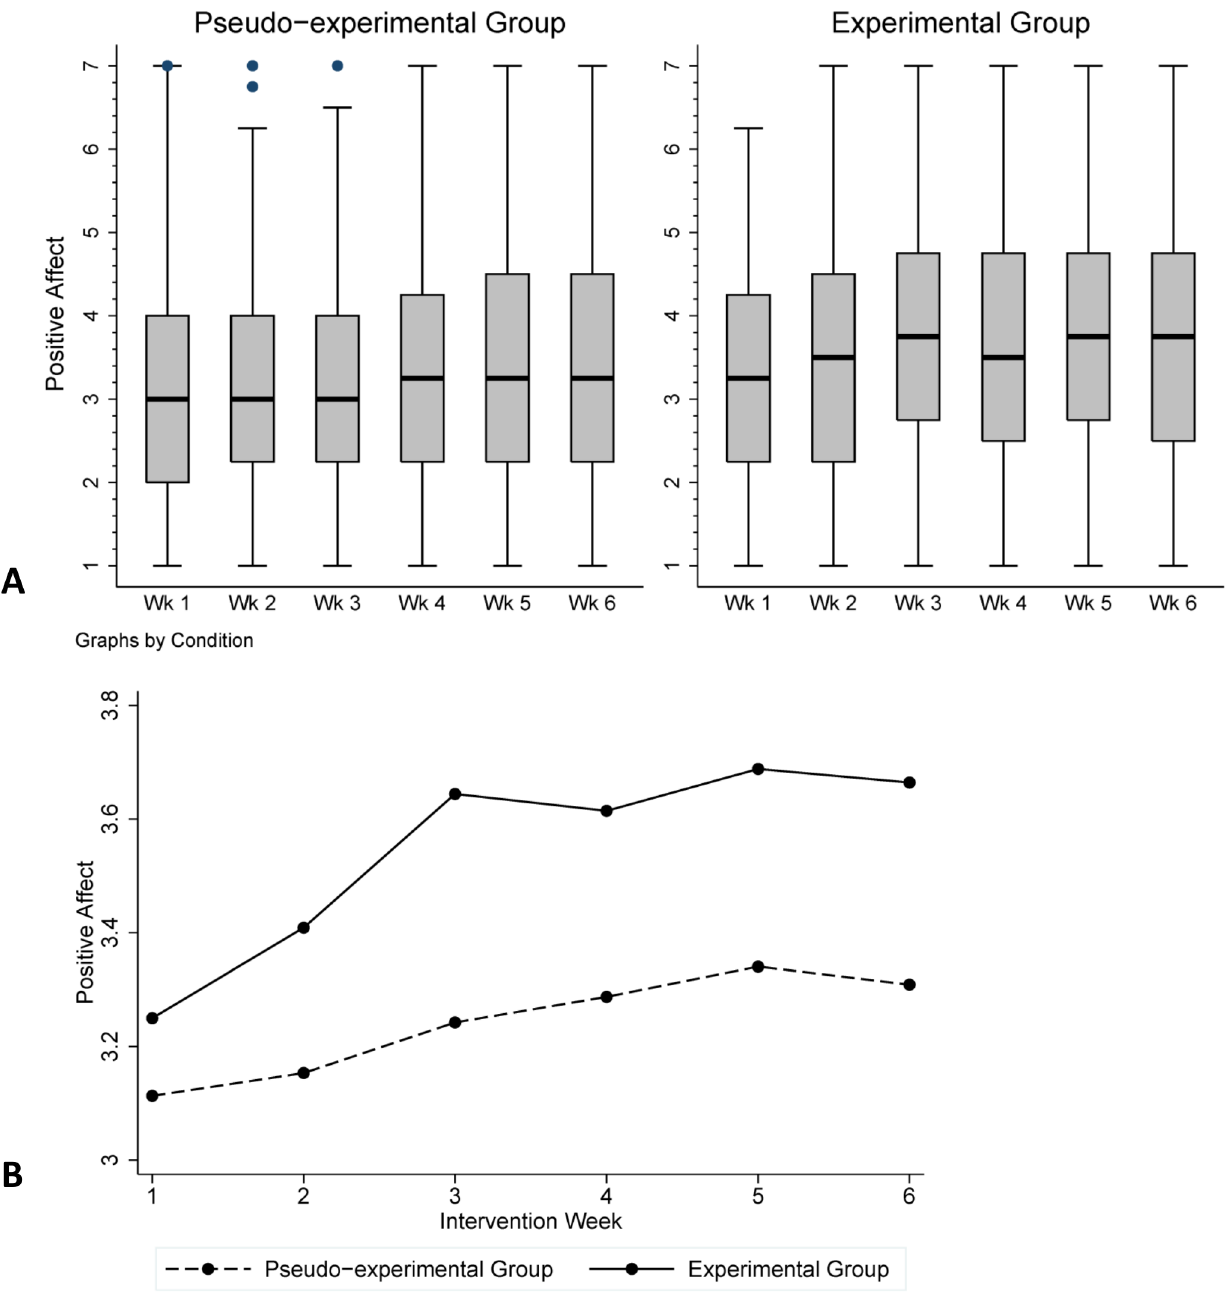
Fig 3. Part A: Box-Whisker plot of PA across the intervention period, by condition. The bottom and top of box indicate first (Q1) and third quartile (Q3), the band indicates the median; whiskers represent upper and lower adjacent values (within Q3+1.5(Q3-Q1) and Q1-1.5(Q3-Q1), respectively. Part B: Means per week across intervention period, by